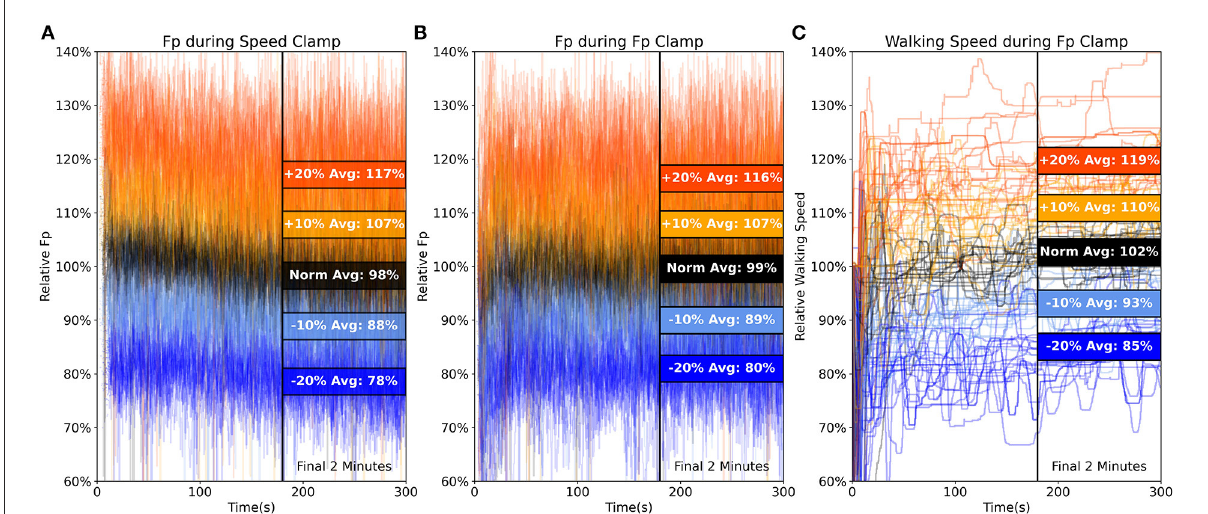
FIGURE3 Here, we show a high-level visualization of the key outcomes from our study over the duration of each experimental trial. Averaged across every step (including left and right sides) during all trials and across all subjects, we show (A) relative F P during the speed clamp, (B) F P biofeedback targeting performance during the F P clamp, and (C) relative instantaneous self-paced walking speed during the F P clamp. In all panels, we also show the group-averaged outcomes over the final 2min in colored blocks for each condition intensity. Overall, participant’s average F P and walking speed over the final 2min generally agreed well with prescribed changes in condition intensity. Early variation in relative walking speed stabilized after the first ∼ 60